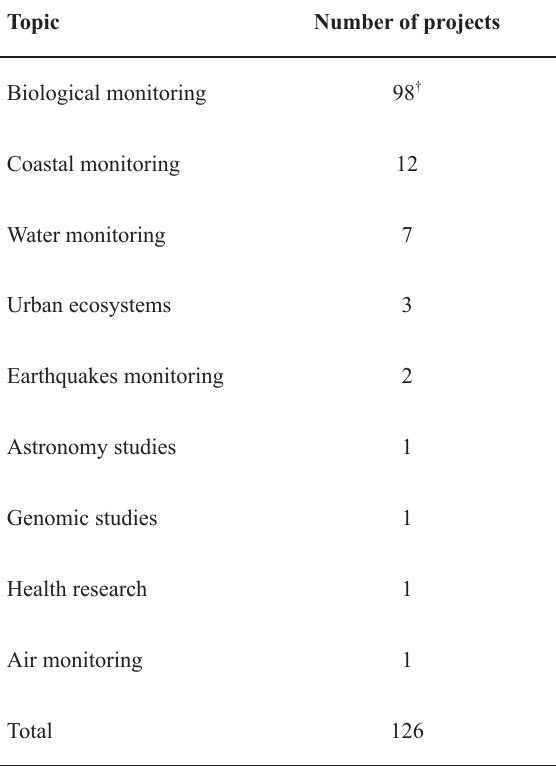
Absolute distribution of the topics addressed by the selected citizen science papers in relation to the monitoring scope.